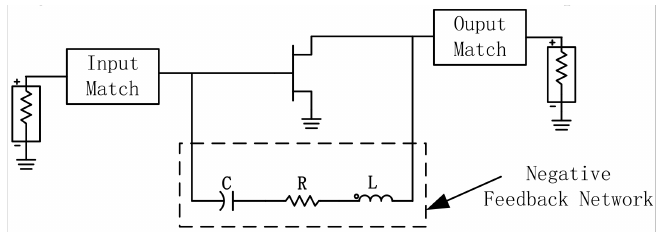
Figure 6. The structure of negative feedback network.